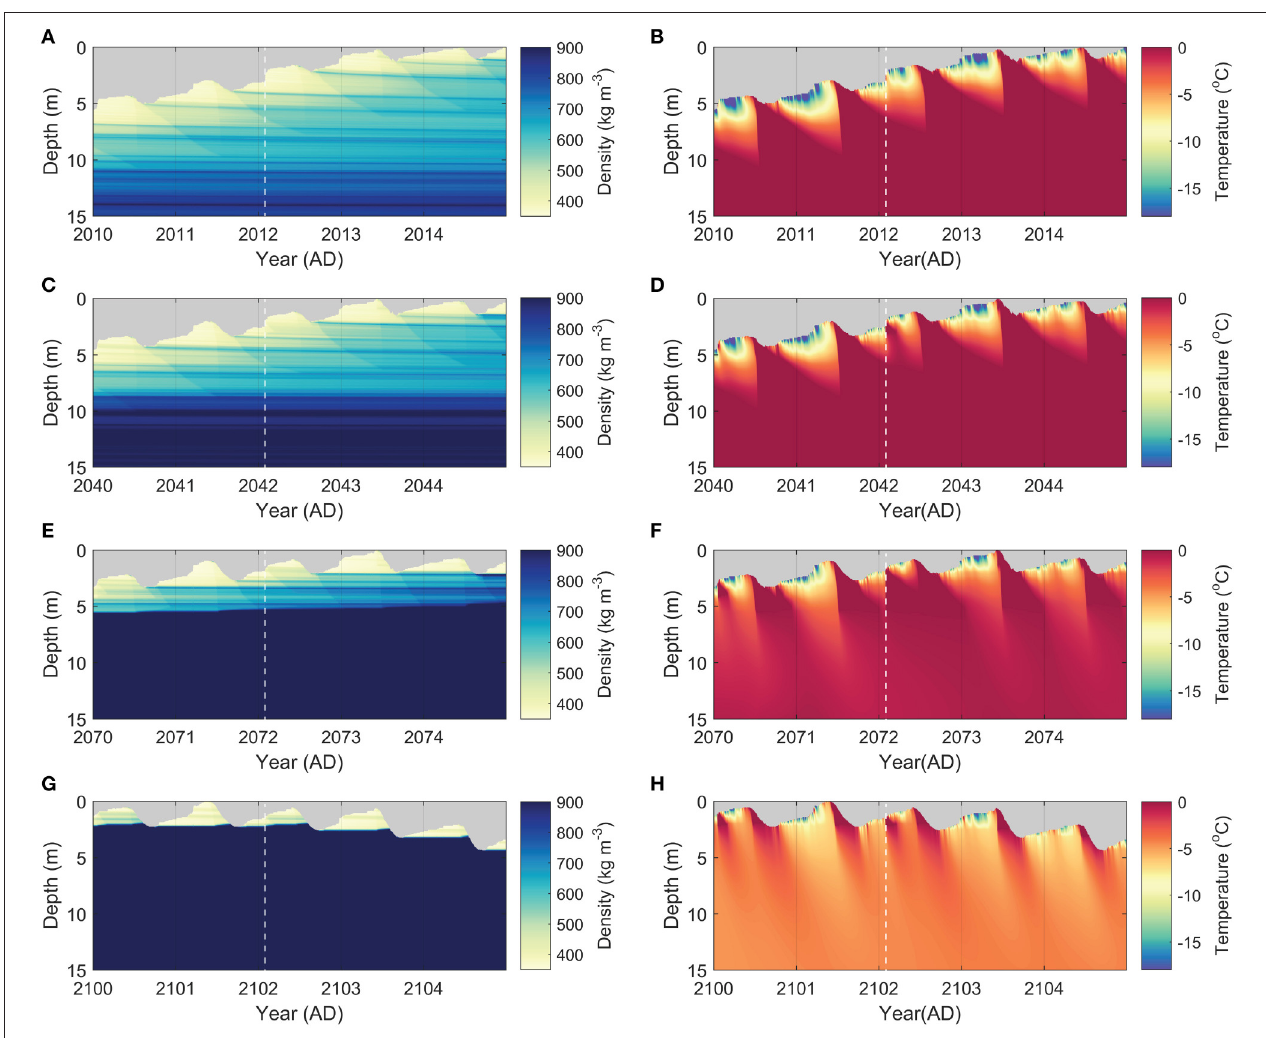
FIGURE 3 | Subsurface density (left) and temperature (right) during the four periods 2010–2014 (A,B) , 2040–2044 (C,D) , 2070–2074 (E,F) and 2100–2104 (G,H) at an elevation of 800m a.s.l. A vertical offset is applied for surface height changes with positive (negative) offsets representing surface height increase (decrease). Surface height changes are defined with respect to the base of the model domain and hence incorporate the effect of firn compaction. Depth on the y-axis is the depth with respect to the highest surface height in the 5-year period. Year labels and tick marks on the x-axis are given at 1 January of the indicated year. The white dashed line marks the onset of the rainfall event in February 2012, 2042, 2072, and